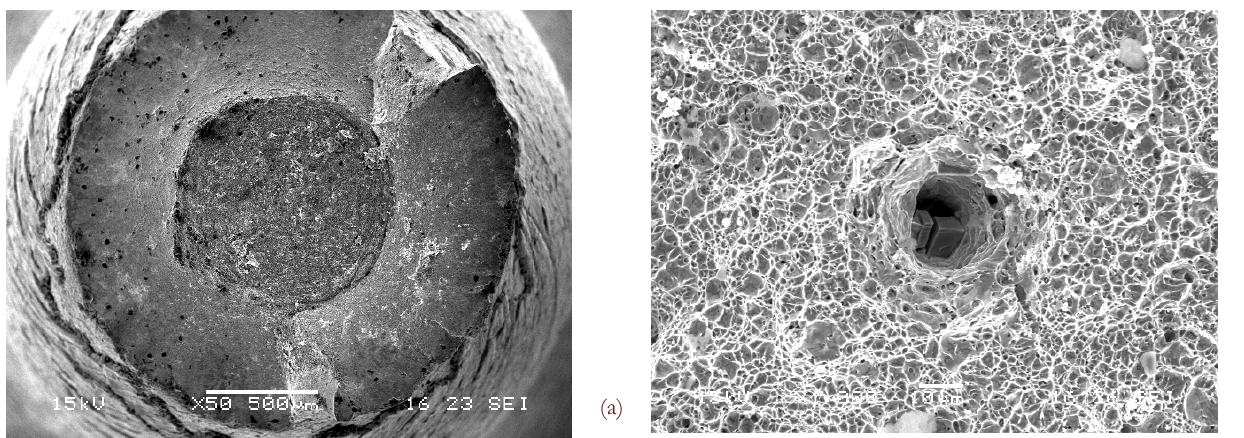
Figure 7: (a) Fracture surface for Maraging 250 specimen peak-aged at 480°C and (b) X1000 magnification for test in 3.5% NaCl aqueous solution with galvanic